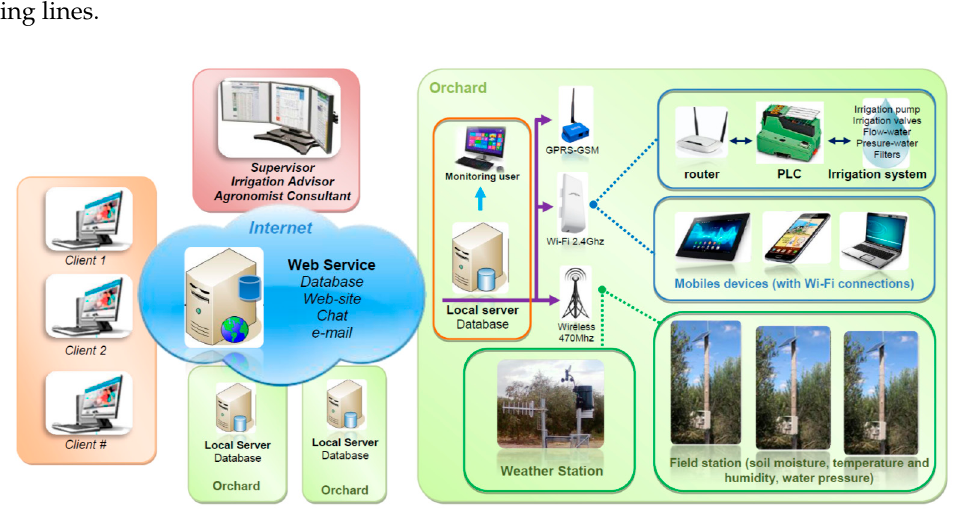
Figure 1. General view of the system developed. The principal components are: in-field devices, the web server, remote clients, and the supervisor.